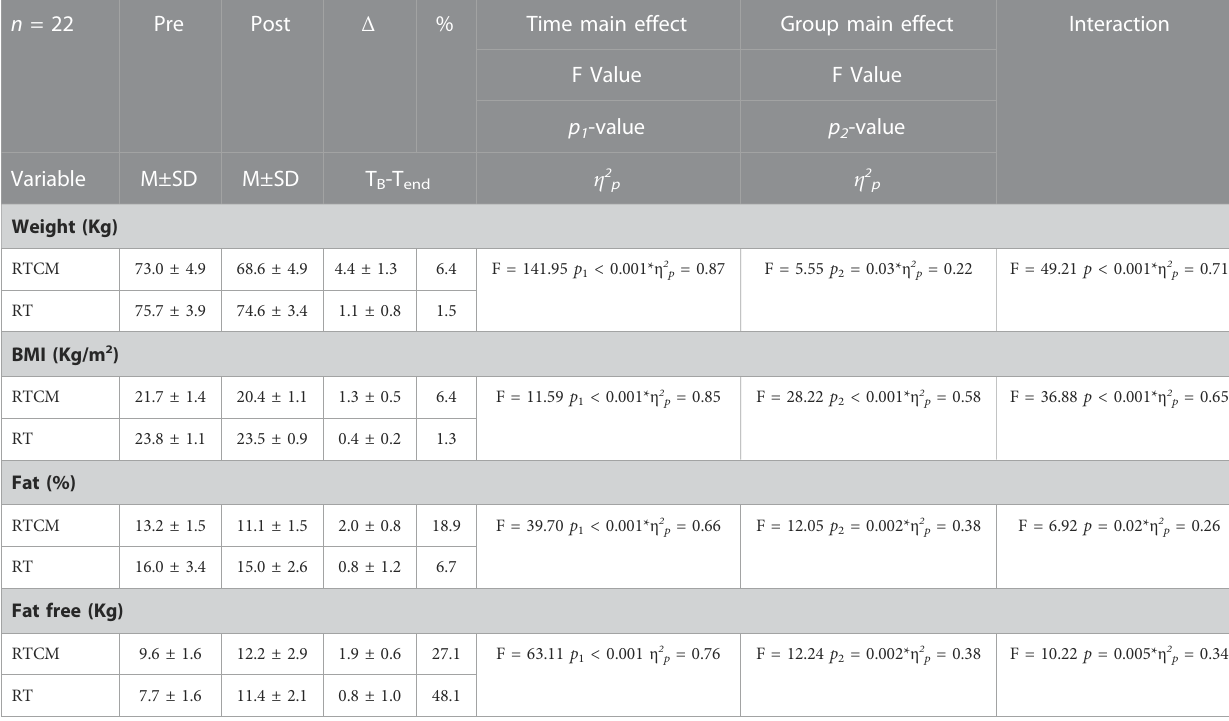
TABLE 3 Anthropometric measurements baseline and after 8-week resistance